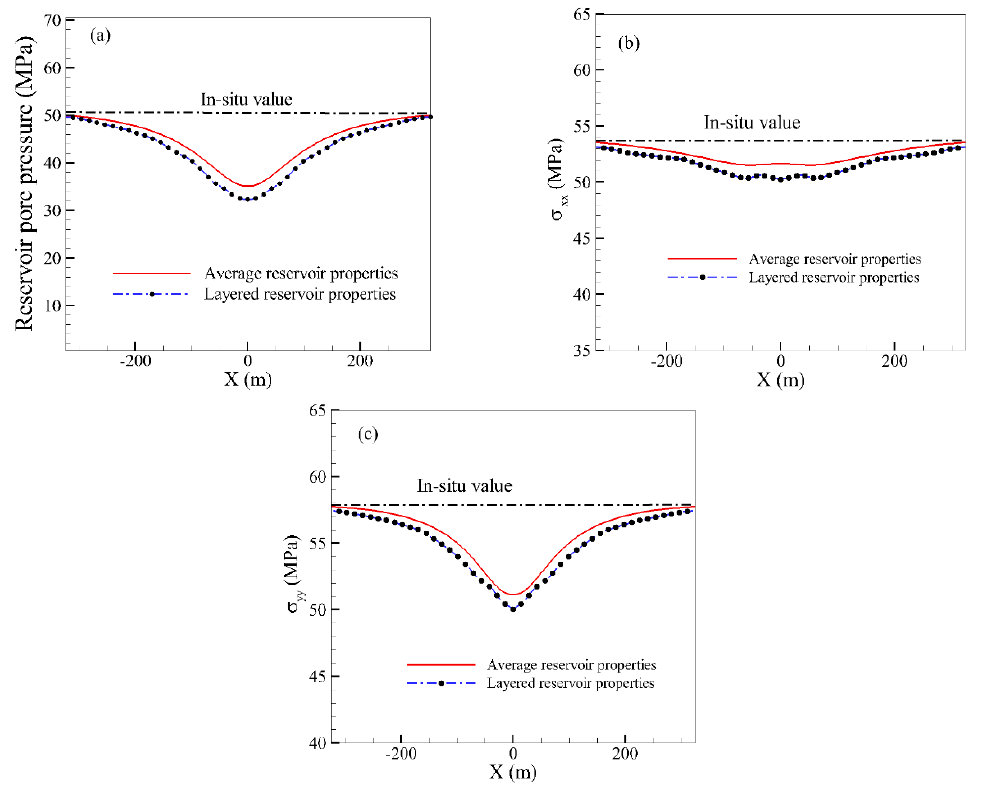
Figure 10. A comparison of the FEM (with layered reservoir properties) and DD model (with average reservoir properties) results for reservoir pore pressure ( a ), horizontal stress component σ xx ( b ), and horizontal stress component σ yy ( c ) along a line in the central XY-plane (dash-dotted “red line” in Figure 7b) after 2 years of production. The results in both cases with average and layered reservoir properties show close agreement with a maximum difference of 6.5%.